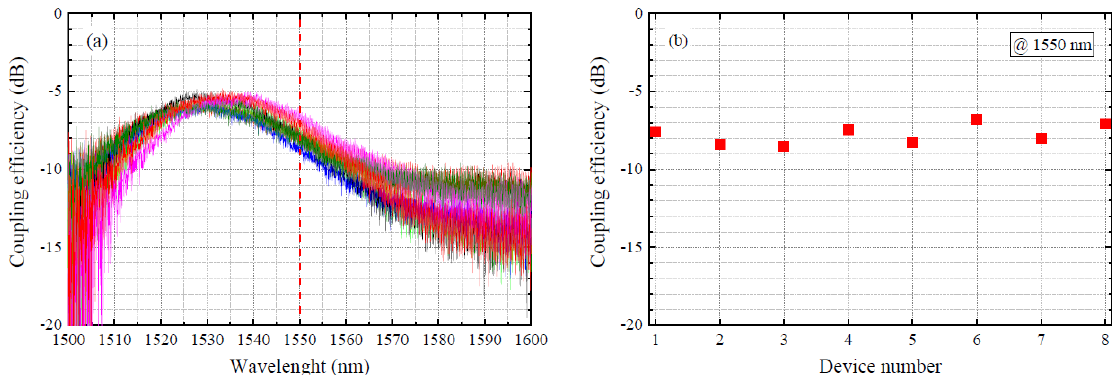
Figure 6. ( a ) Grating coupler wavelength response on the eight measured samples. The coupling efficiency peaks at 1535 nm and is still acceptable at 1550 nm. ( b ) Coupling efficiency at 1550 nm of